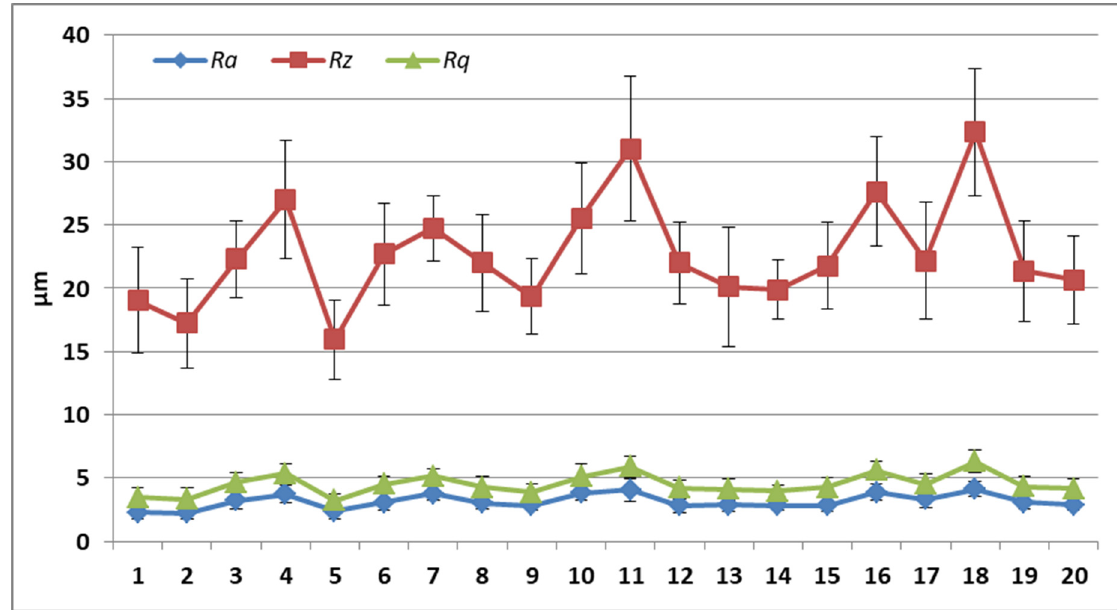
Figure 15. Mean values of surface roughness parameters Ra, Rz and Rq (µm) for the pellets .